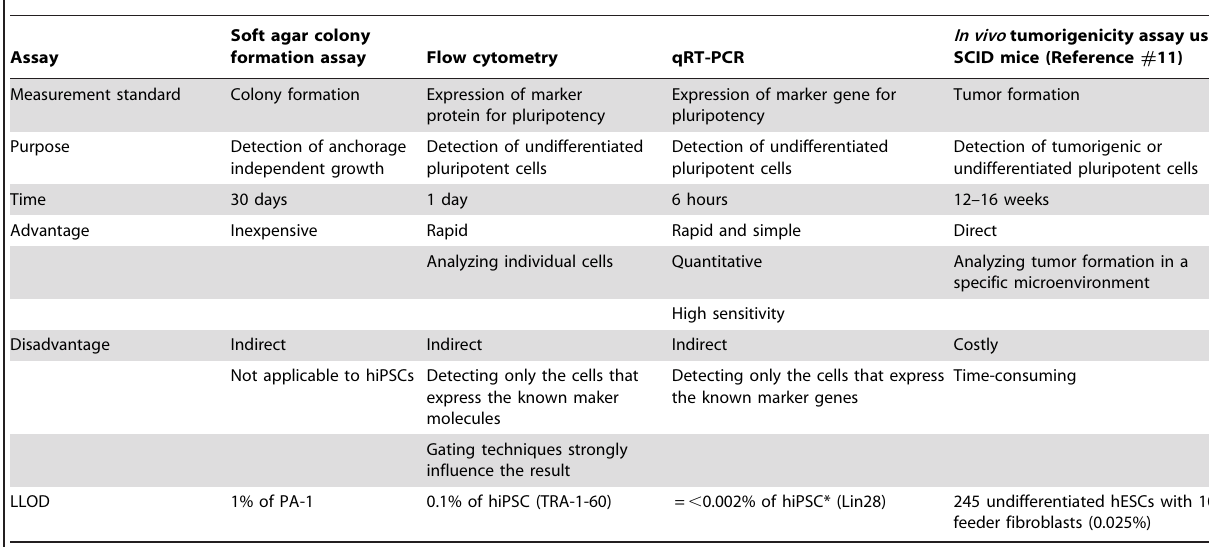
Table 1. Comparison of the tumorigenicity-associated